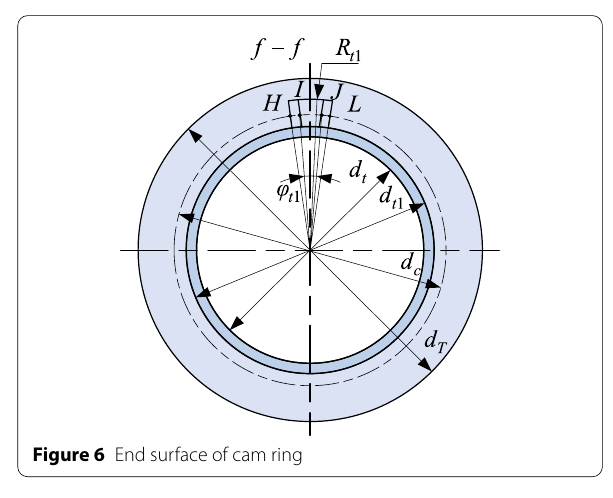
Figure 6 End surface of cam ring